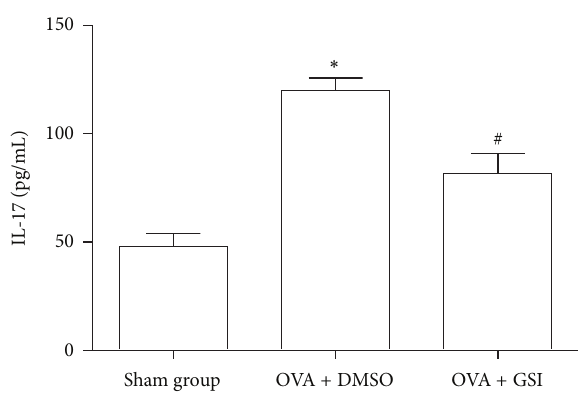
Figure 5: GSI administration reduced production of IL-17. Serum IL-17 levels were measured from sham, OVA, and OVA plus GSI groups using standardized sandwich ELISA. Data expressed here are Mean ± SEM. 𝑁 = 8 . ∗ 𝑃 < 0.01 compared with the sham group. # 𝑃 < 0.01 compared with the vehicle group.